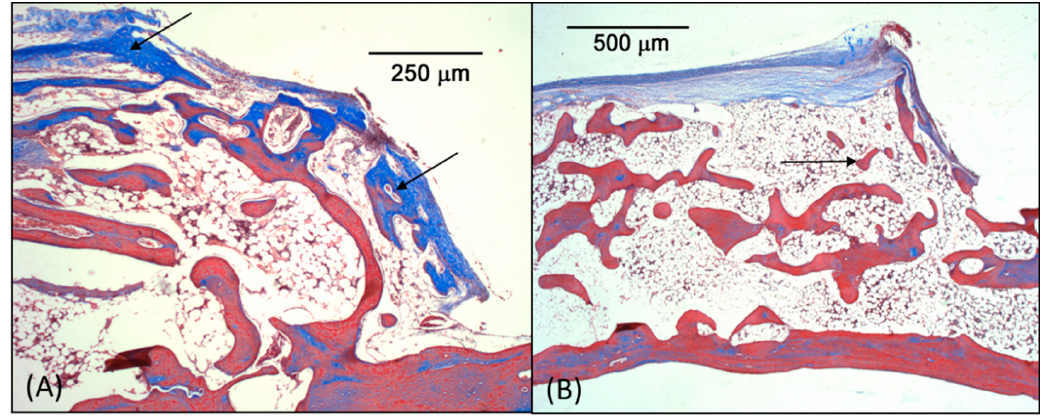
Figure 10. Microscopic images from Group 4: ( A ) Newly formed bone reaching the limits of the dome (black arrows). ( B ) Lamellar bone tissue dispersed within the dome.